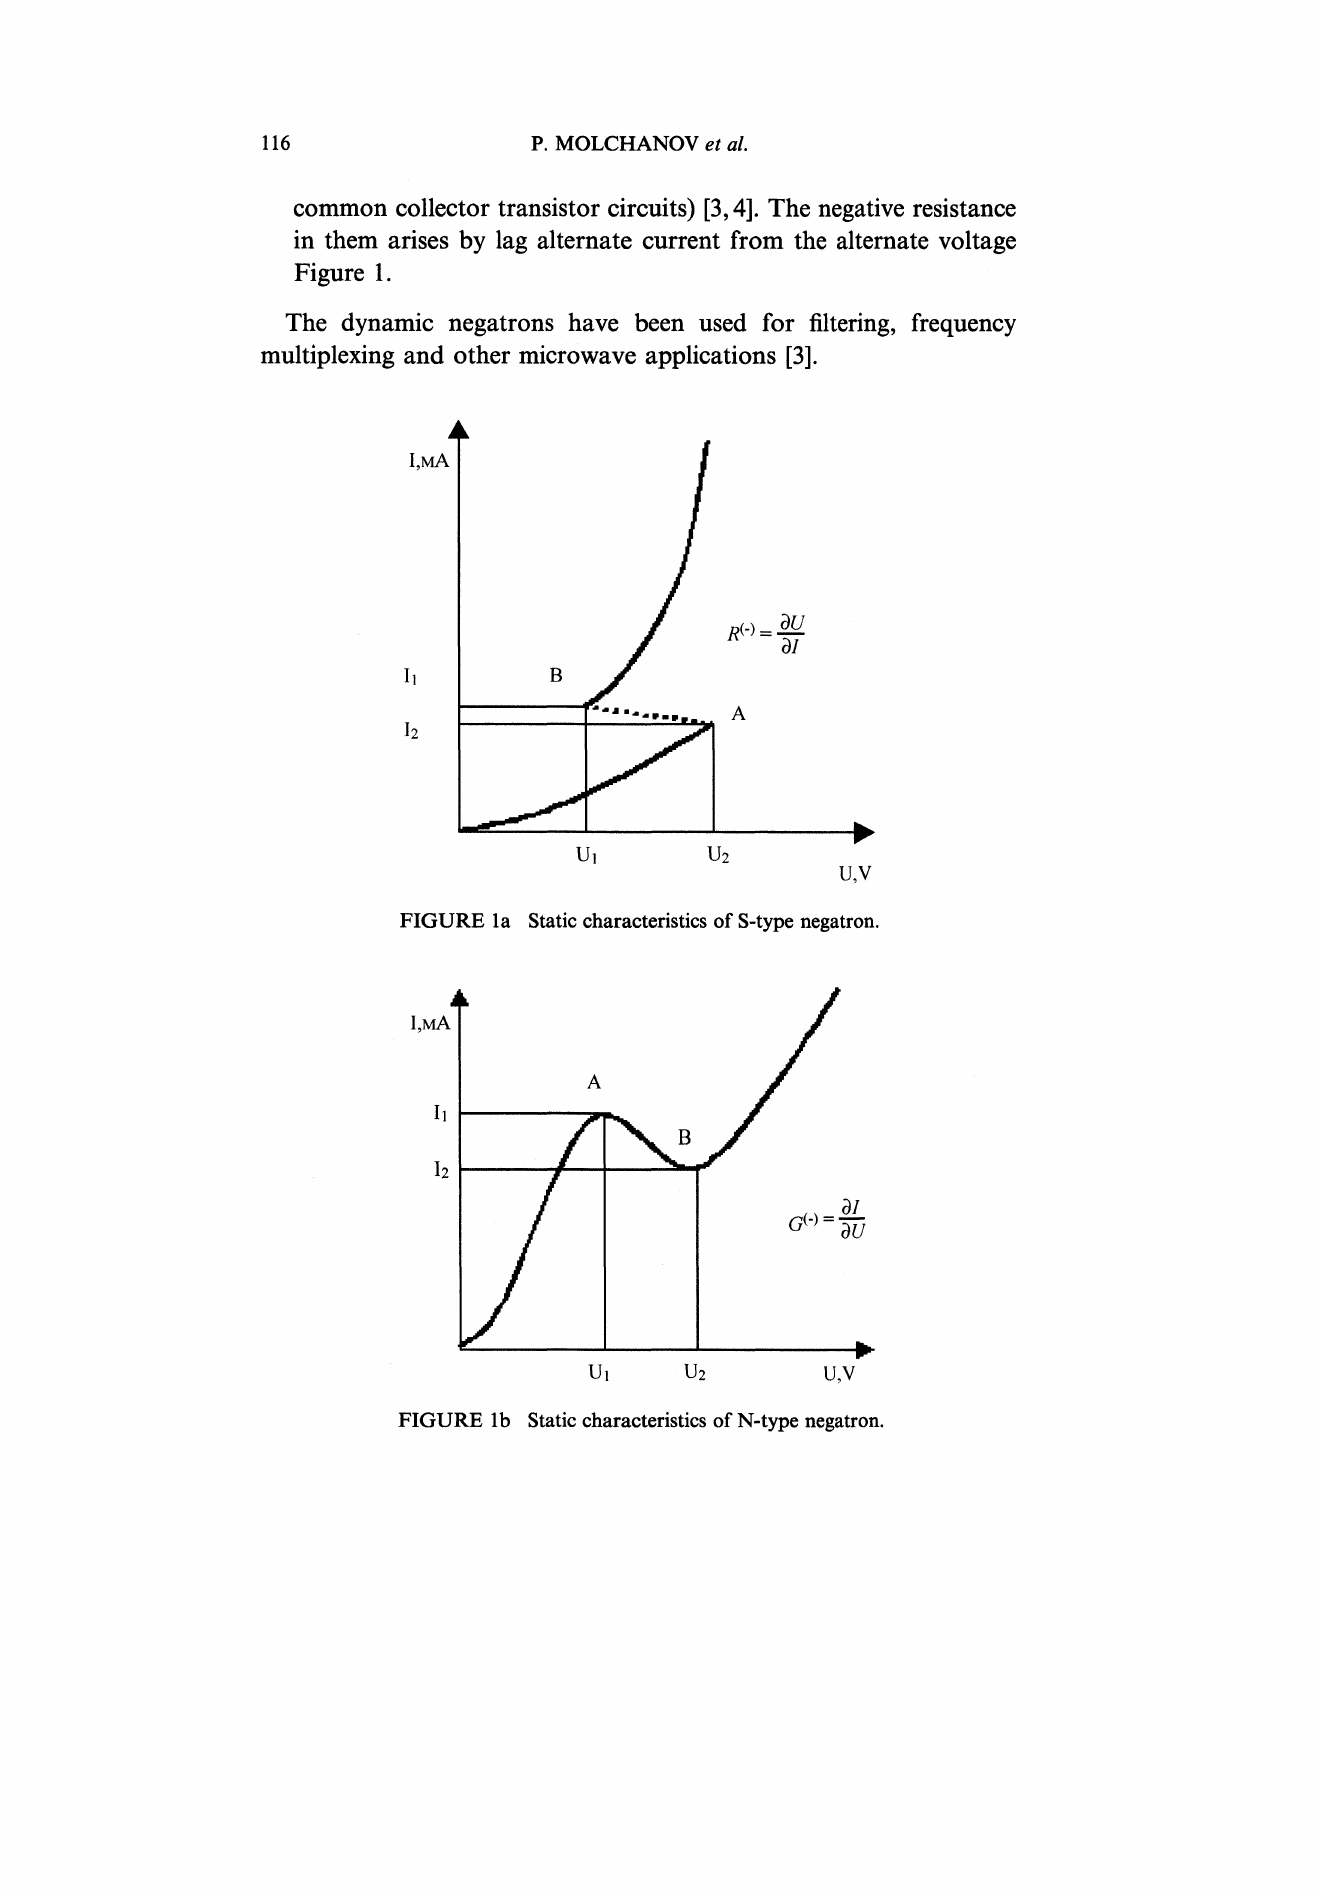
FIGURE lb Static characteristics of N-type